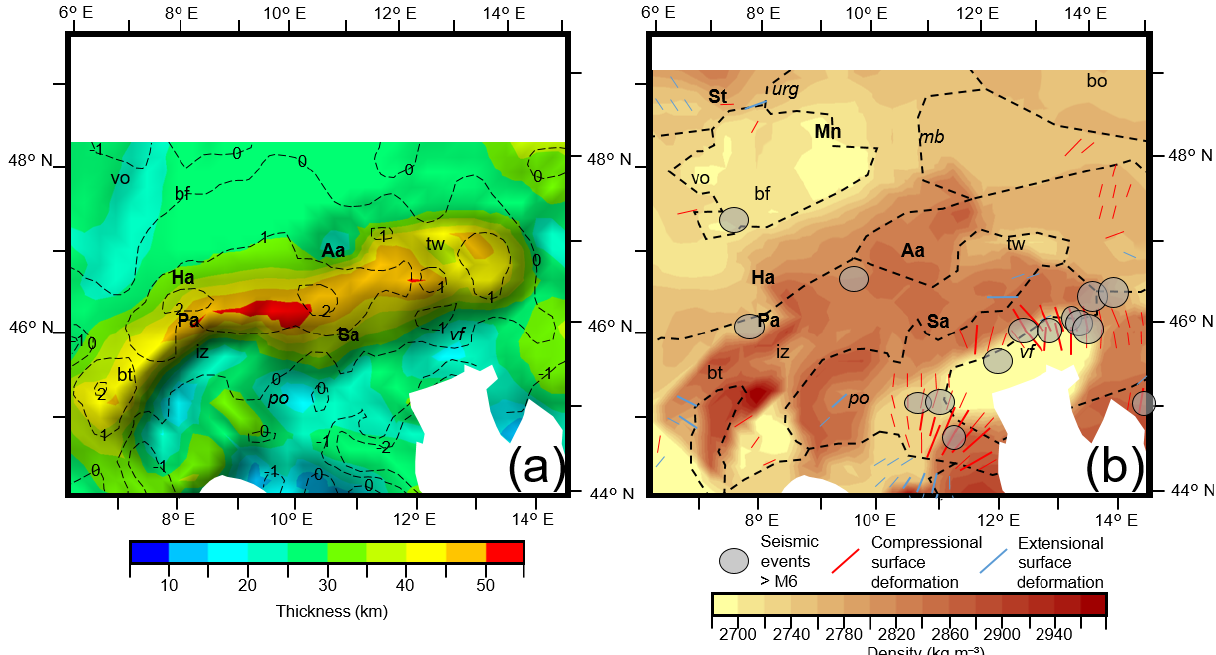
Figure 8. (a) Thickness of the crust across the modelled area overlaid with vertical displacement rates (Sternai et al., 2019). Dotted black lines indicate isolines of the vertical displacement rates in millimetre per year. (b) Average density of the crust across the modelled area overlaid with geodetically derived horizontal surface strain distribution (Sánchez et al., 2018) and seismic events of a moment magnitude larger than 6 (Fäh et al., 2011; Stucchi et al., 2012; Grünthal et al., 2013). Bar orientation indicates orientation of maximum surface strain. Dotted black lines indicate the upper-crust density domains of the final structural and density model. Regions where the overlaid data were not available have been whited out in both figures. Locations of key tectonic features are overlaid for both figures (abbreviations shown in Fig. 1a